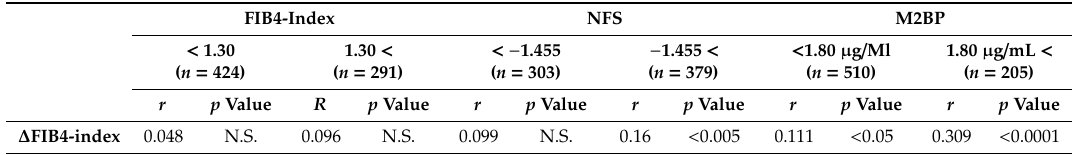
Table 5. Correlations between FIB4-index, NFS, or serum M2BP levels at baseline and changes